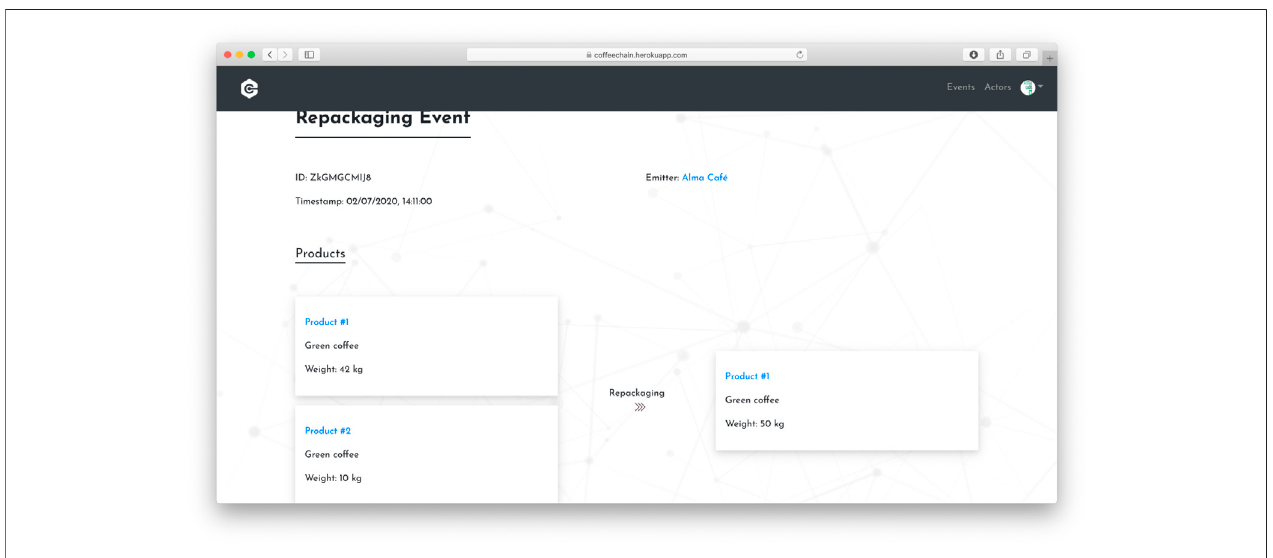
FIGURE 5 | Event view of